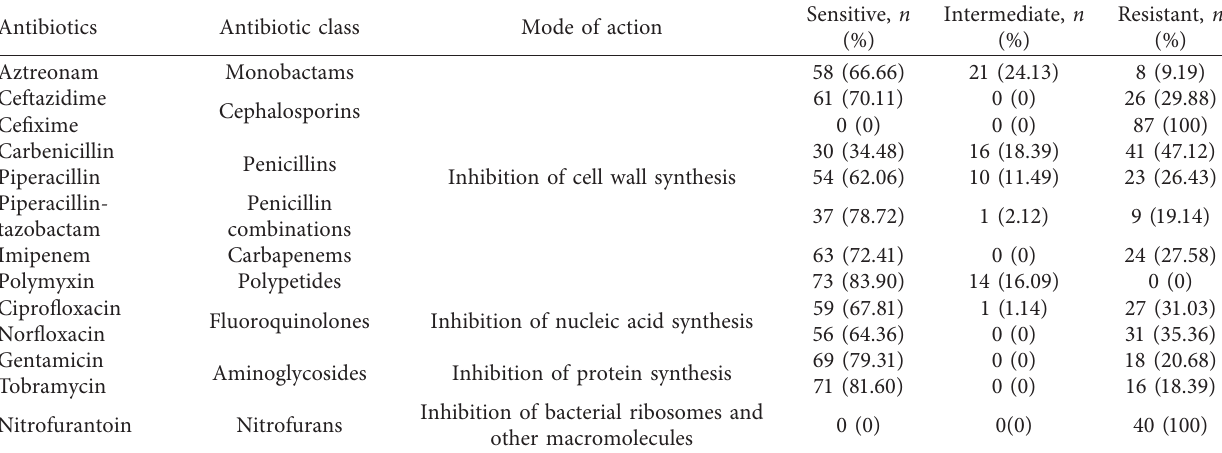
Table 3: Antibiotic susceptibility pattern of P . aeruginosa .